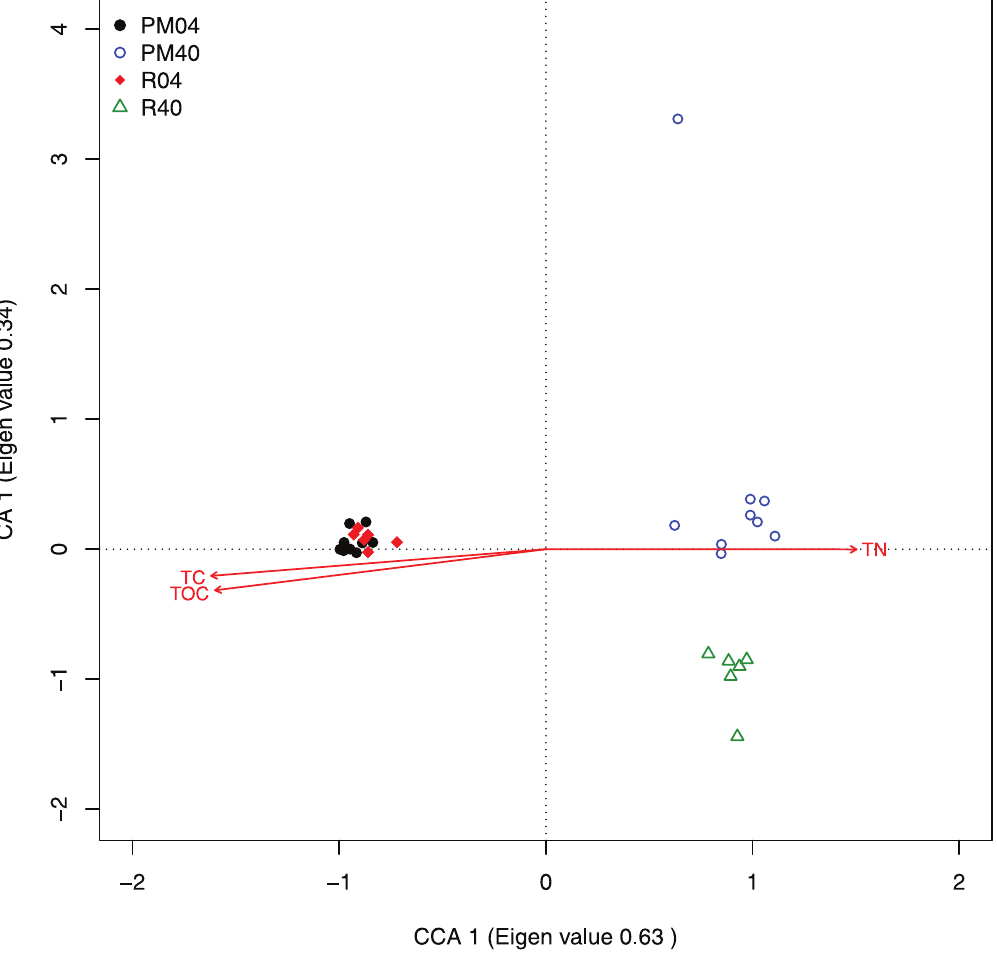
Figure 5. Relationships between bacterial communities of Oslofjord sediments using constrained correspondence analysis. Two- dimensional CCA ordination of the samples using one constrained axis (CCA 1) and an unconstrained axis (CA 1). The constraining factor was Total Carbon. Eigenvalue for both axes are indicated beside each axis. Environmental parameters that significantly (p , 0.01) correlated with the ordination were fitted using the envfit command (Vegan package). Abbreviations: total nitrogen (TN), total carbon (TC), total organic carbon (TOC).